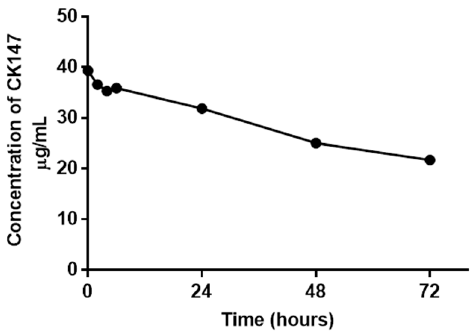
Figure 2. PSMA-targeted CHKA inhibitor (CK147) concentration trend (72 h) in medium supple- mented with 10% FCS (60 ± 0.3% intact parent at 72 h); n = 3, mean ± SD.